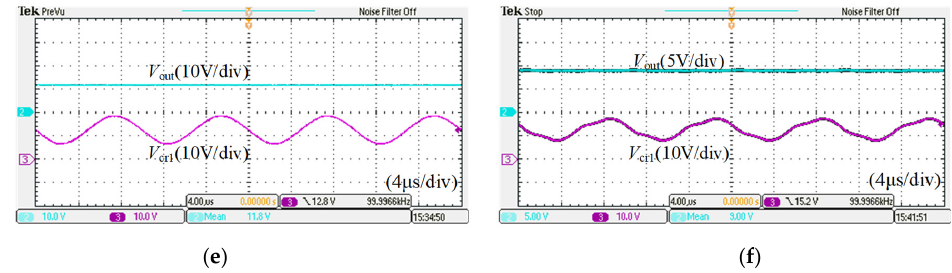
Figure 18. Wide ‐ output experimental verification waveform. ( a ) V out = 35 V; ( b ) V out = 24 V; ( c ) V out = 16.5 V; ( d ) V out = 17.5 V; ( e ) V out = 11.8 V; ( f ) V out = 9 V. The lower limit of the output voltage in the full ‐ bridge frequency modulation mode is also the output upper limit of the full ‐ bridge phase ‐ shift mode, and the phase ‐ shift angle is 0. The controller can continue to reduce the voltage by increasing the phase ‐ shift angle. When the output voltage V out = 16.5 V, the lower limit of the output voltage of the full ‐ bridge phase ‐ shift mode is reached, as shown in Figure 18c. The phase ‐ shift angle α = 0.54 π and the amplitude of the resonant capacitor voltage V cr1 is 10 V. The upper limit of the output voltage in the half ‐ bridge FM mode is set to 17.5 V, as shown in Figure 18d. The circuit switching frequency f s = 53 kHz, the resonant capacitor voltage V cr1 is a sine wave with a DC offset of 12.5 V and its amplitude is 25 V; when the switching frequency reaches the resonant frequency, the output voltage V out = 11.8 V and the amplitude of the resonant capacitor voltage V cr1 is 6 V, as shown in Figure 18e. mode needs to reach is 9 V. At this time, the phase ‐ shift angle α = 0.52 π and the amplitude